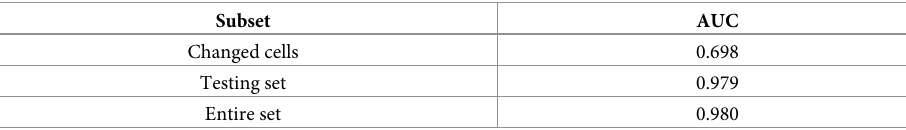
Table 7. Area under the ROC curve (AUC) for three validation